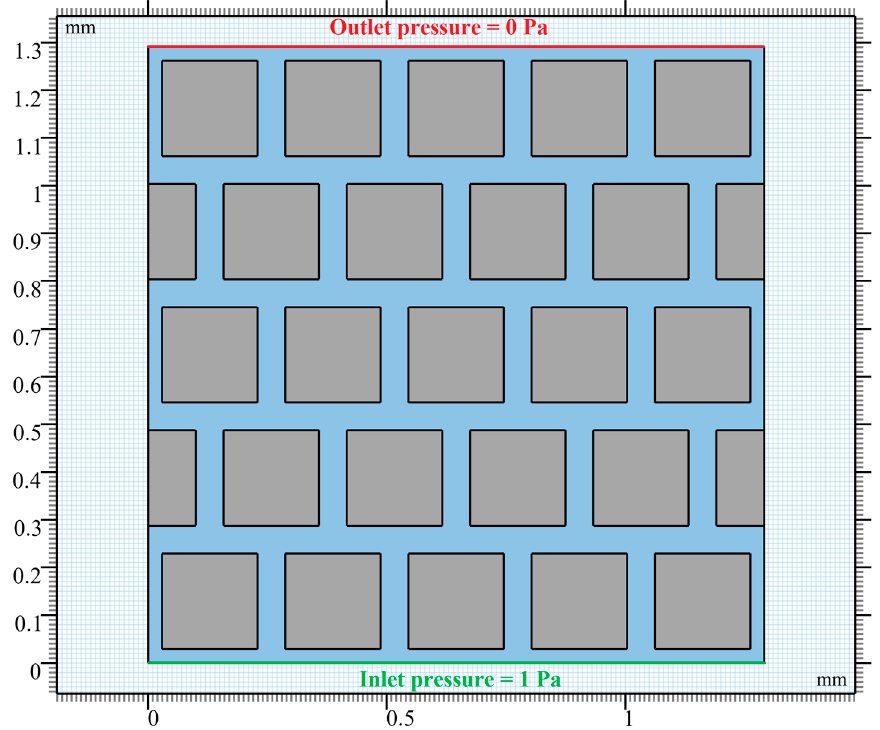
Figure 2. COMSOL basic geometric model (grey region: bentonite; blue region: chemical solution).